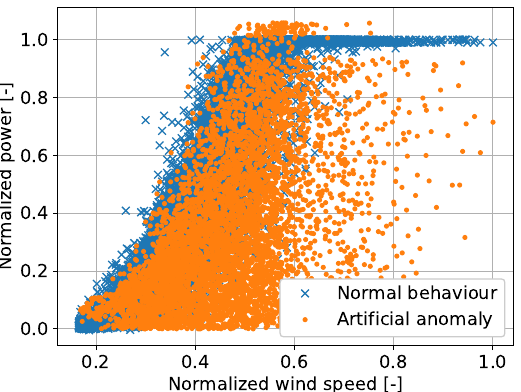
Figure 14. Data set with artificially introduced anomalies for hyperparameter tuning of autoencoder model.